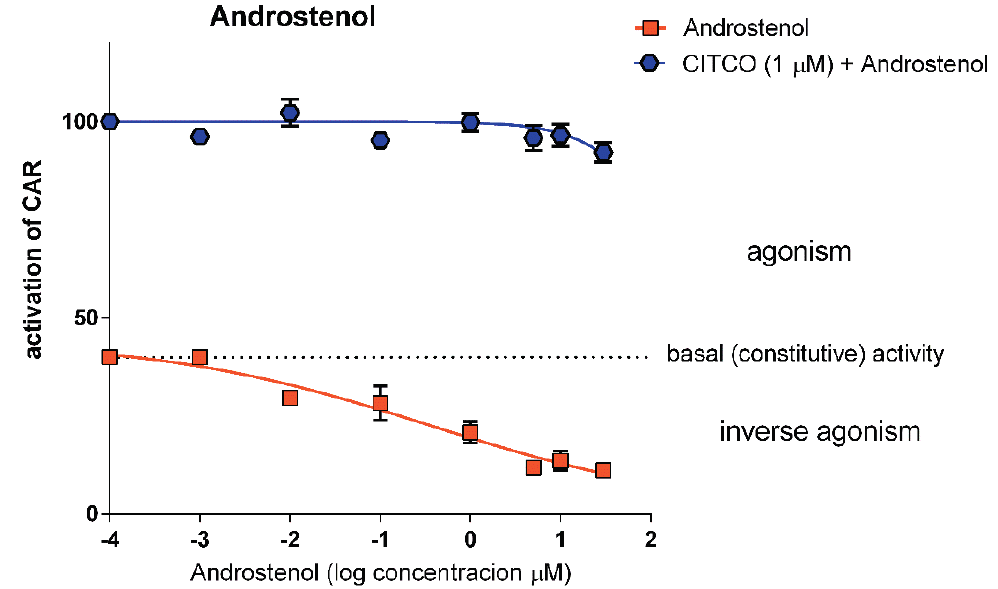
Figure 4. Effect of androstenol on CAR LBD activity in the TR-FRET LanthaScreen TM CAR Coactivator Assay. Androstenol in a serial dilution was tested in inverse agonistic or antagonistic modes together with the prototype CAR agonist CITCO (1 μ M concentration) using the TR-FRET assay. Data are presented as the relative activation to background activity (set to 0%) and to the effect of CITCO (1 μ M) set as 100% activation. The dotted line represents constitutive activity of CAR LBD (vehicle-treated samples). Data